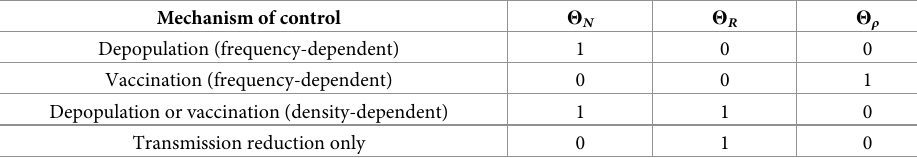
Table 1. Different types of outbreak mitigation efforts can be